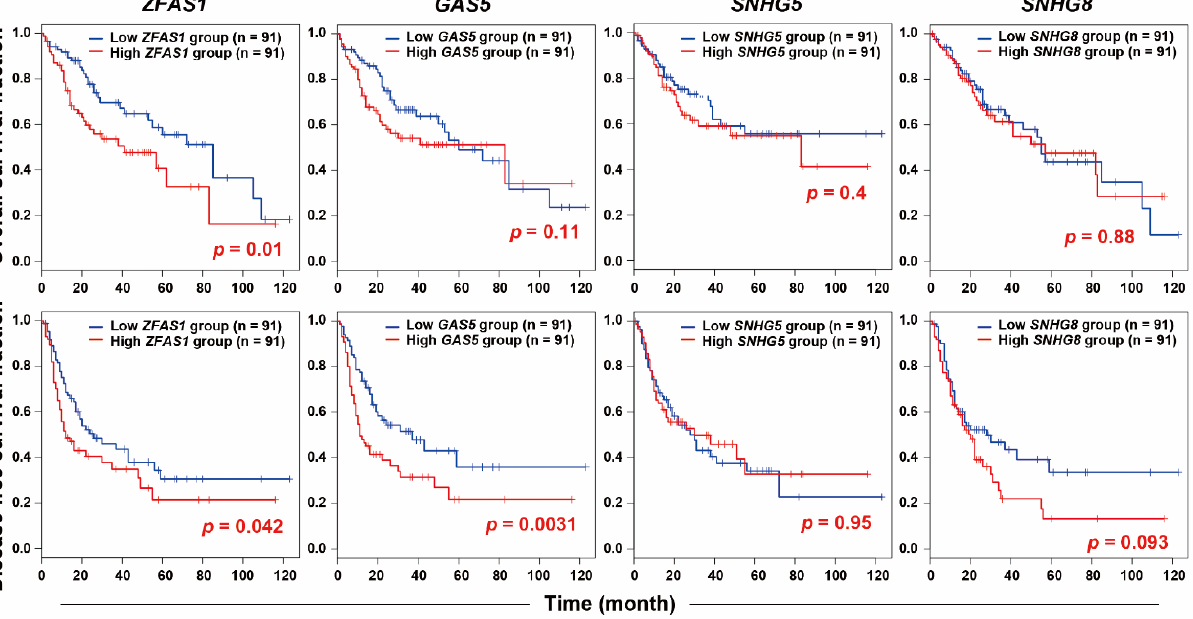
Figure 3. The prognostic values of lncRNAs in HCC. The Kaplan–Meier plots for the relationship between lncRNA expression and overall/disease-free survivals were generated from the GEPIA database. The group cut-off value was set as “quartile”.